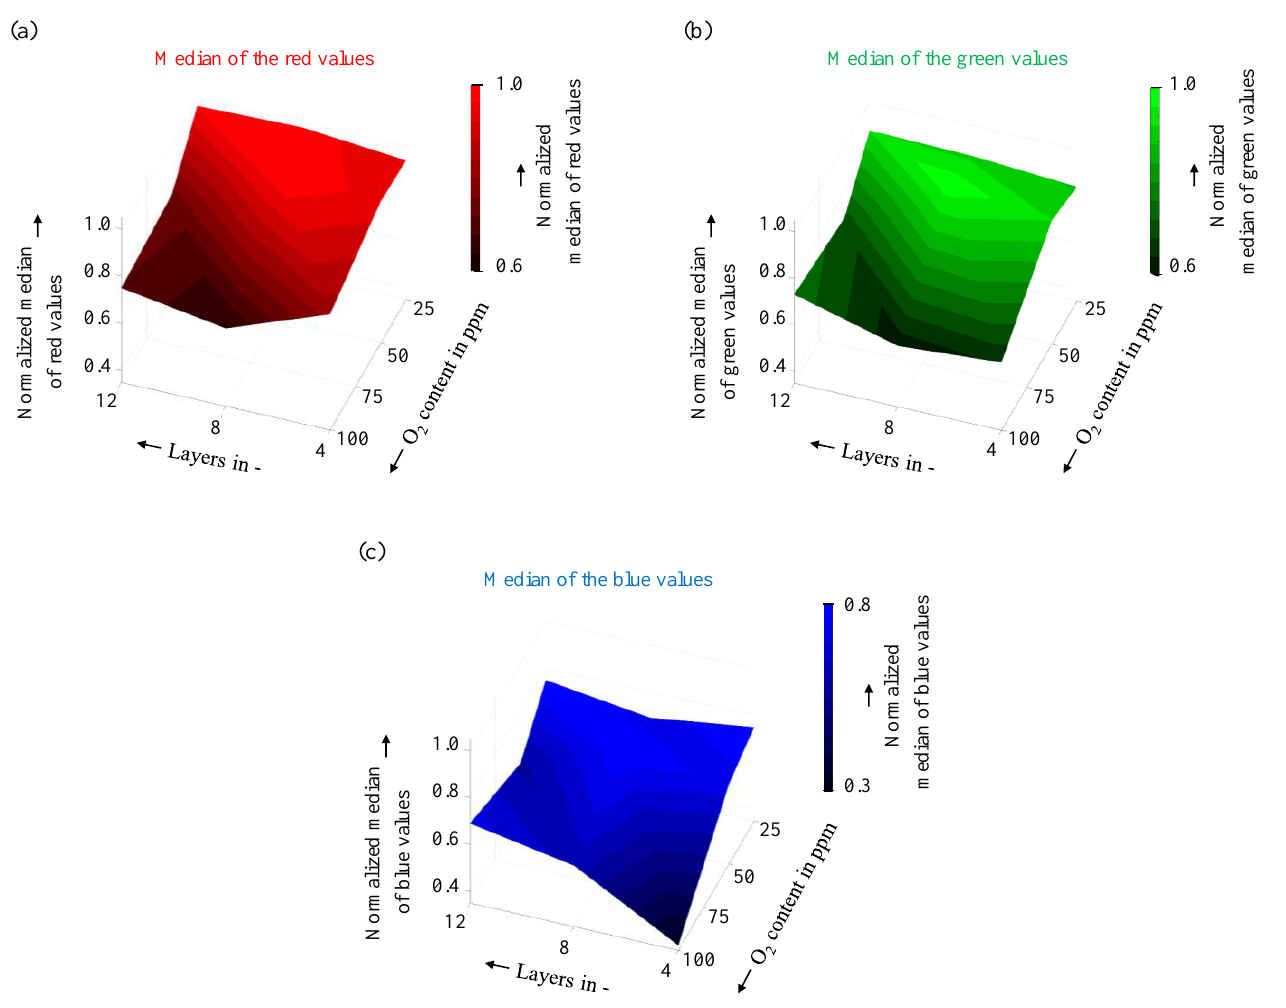
Figure 9. Normalized medians of the ( a ) red, ( b ) green, and ( c ) blue values plotted over the number of layers and the oxygen content of the manufactured walls.